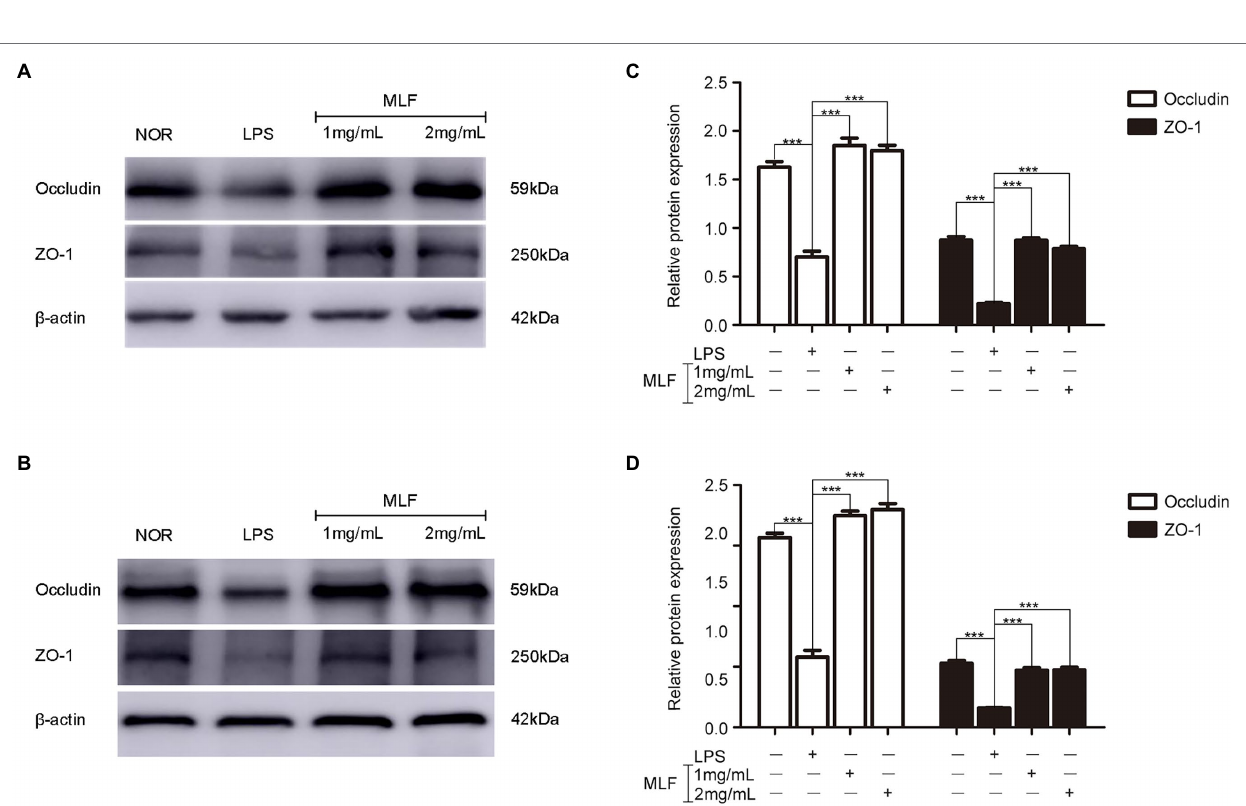
FIGURE 3 | The mRNA levels of IL-1 β , IL-6, and TNF- α in caco-2 cells. IL-1 β (A) , IL-6 (B) , and TNF- α (C) mRNA levels were examined in Caco-2 cells which were pretreated with 50